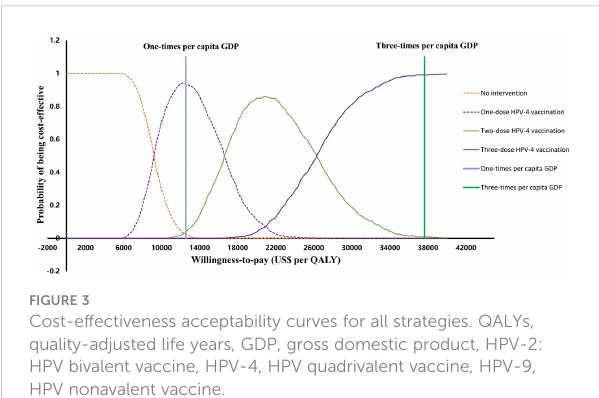
FIGURE 3 Cost-effectiveness acceptability curves for all strategies. QALYs, quality-adjusted life years, GDP, gross domestic product, HPV-2: HPV bivalent vaccine, HPV-4, HPV quadrivalent vaccine, HPV-9, HPV nonavalent